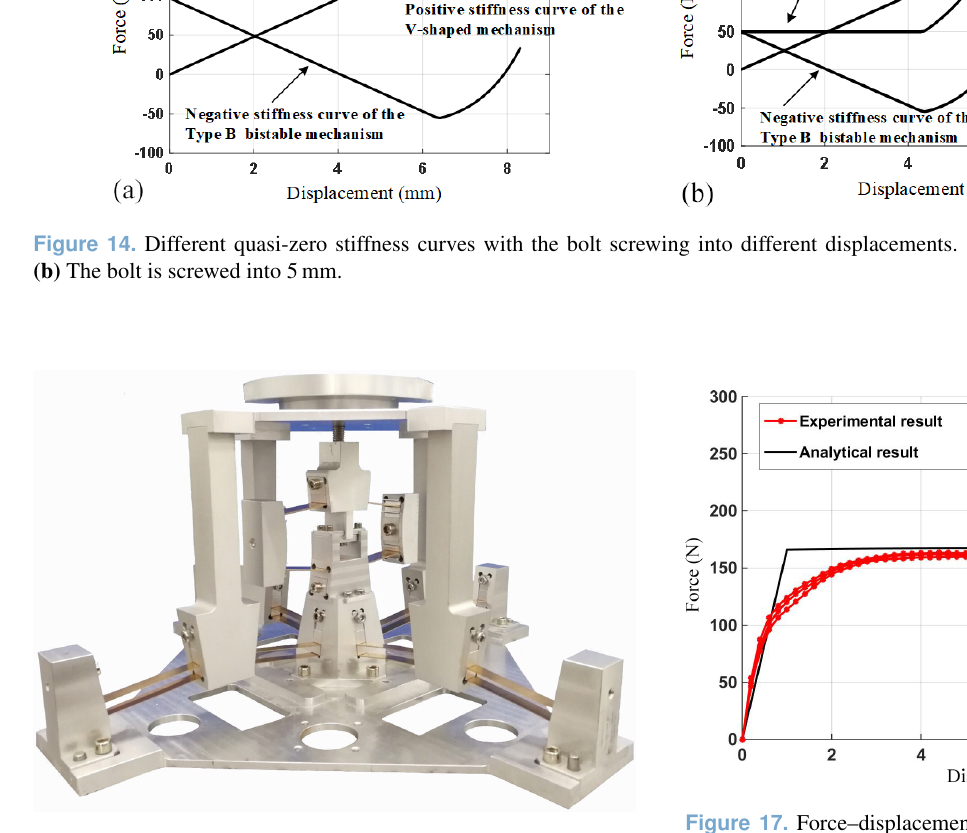
Figure 15. Prototype of the designed quasi-zero stiffness stage.